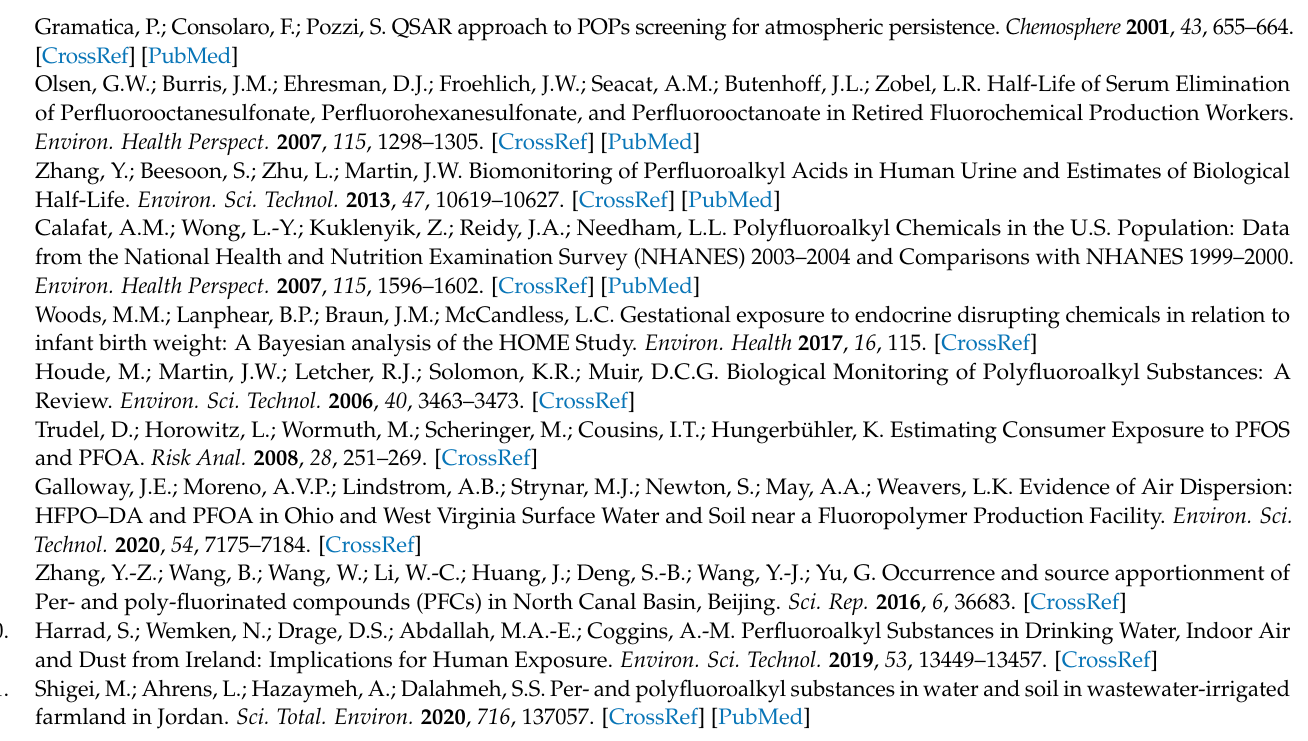
Figure S6. Funnel plot of maximum quartile polyfluoroalkyl substances and ASD. (A: PFOA; B: